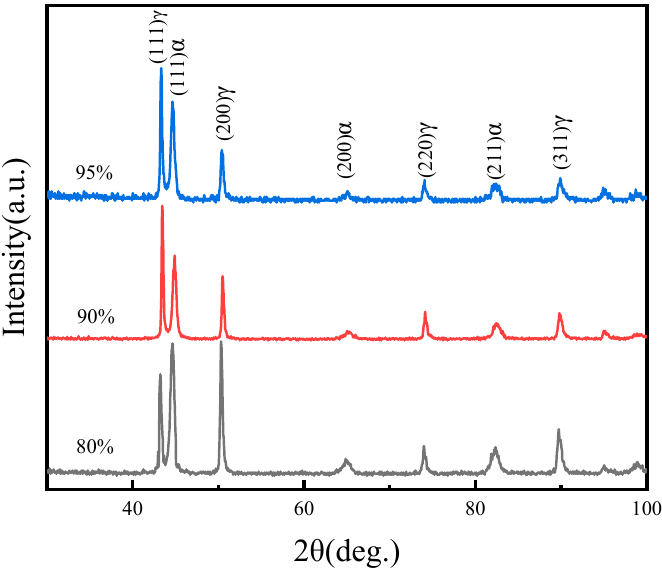
Figure 12. XRD patterns of TWIP/40Si2CrMo multilayer steels at different hot rolling reductions. The dislocation density is calculated as shown in the equation: